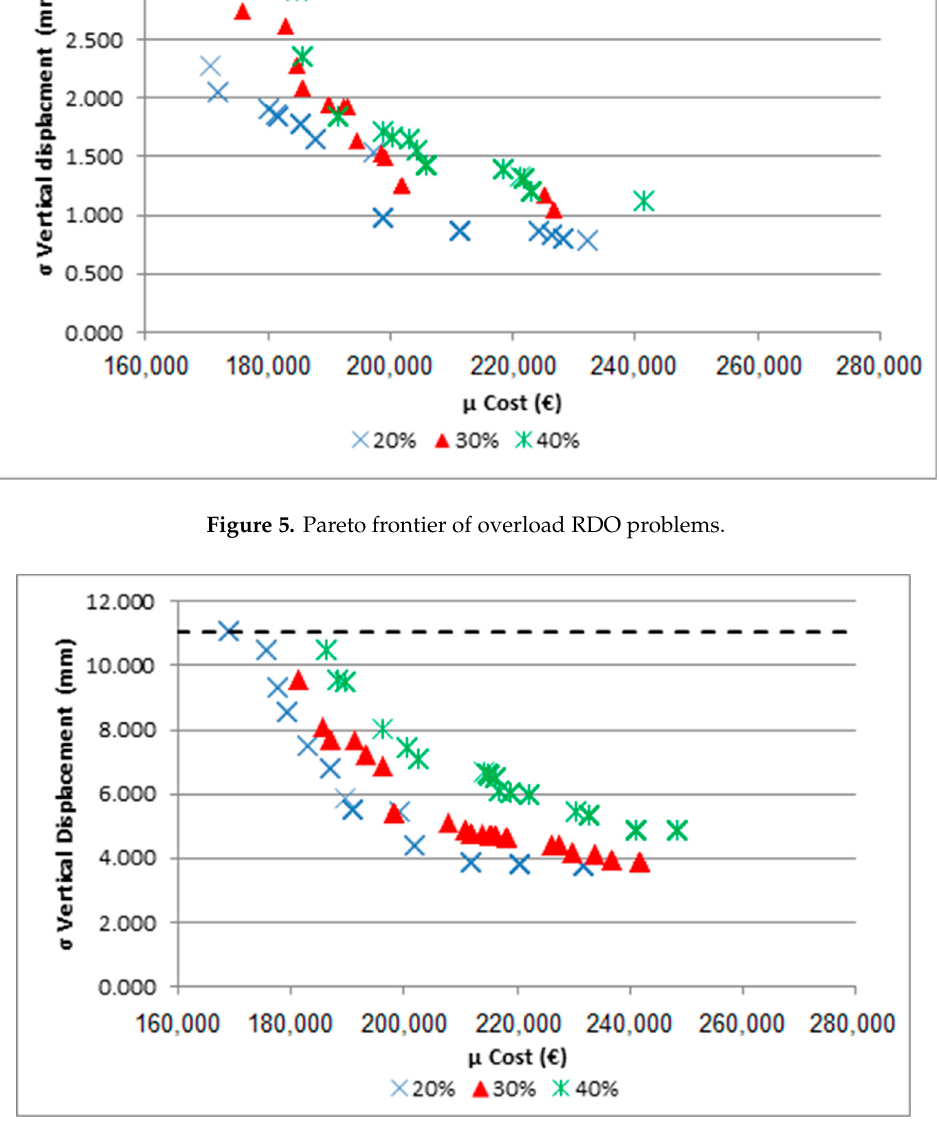
Figure 6. Pareto frontier of prestressing force RDO problems. Table 10. Comparison of designs with the same structural behavior in prestressing force RDO Table 8. Comparison of designs with the same structural behavior in overload RDO problems.